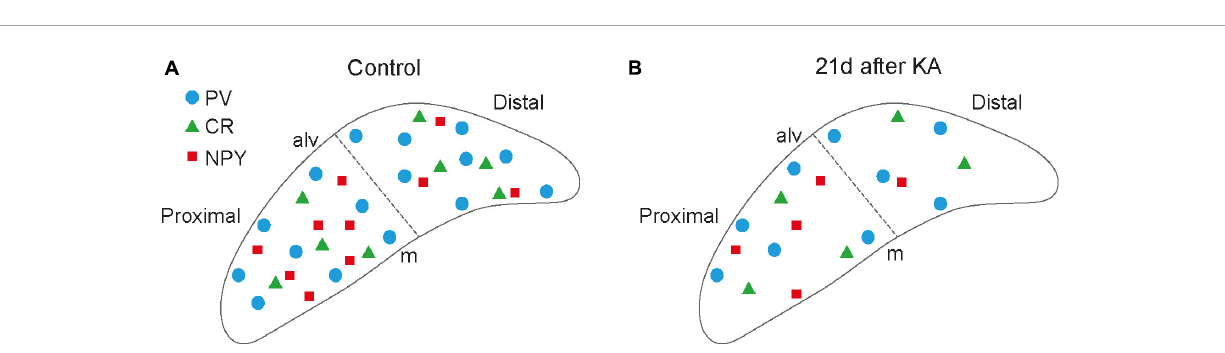
FIGURE6 Schematic summary figure. Schematic illustration of placement of subicular interneurons under control (A) versus epileptic conditions 21 days after kainate (KA) (B) in the pyramidal cell layer of the subiculum at the level of the injection site. Individual interneuron types are given in the legend. NPY + neurons in the scheme only correspond to NPY-expressing interneurons (i.e., Gad67 mRNA-positive). alv, alveus; m, molecular